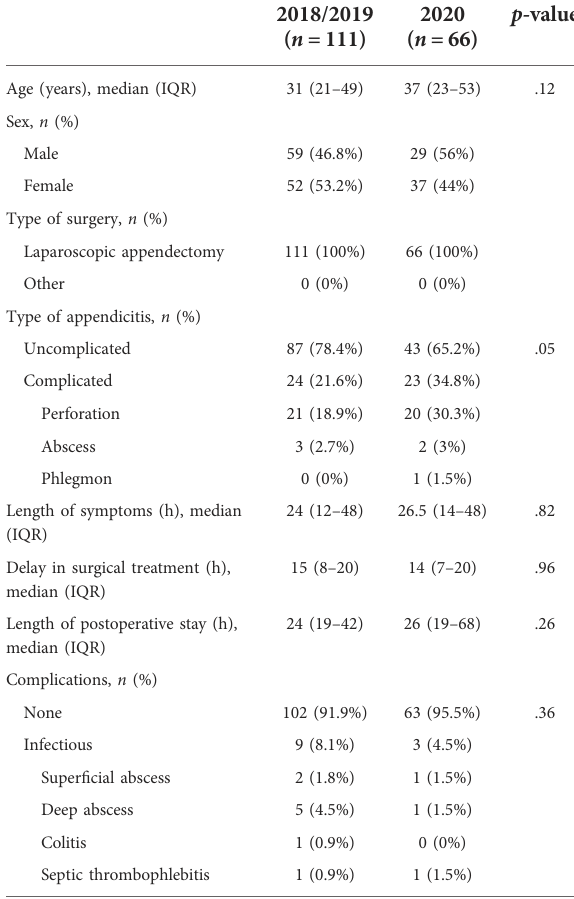
TABLE 1 Demographics, severity of appendicitis, delay before consultation, delay to surgery, and postoperative outcomes in pre- COVID (2018/2019) and COVID (2020)